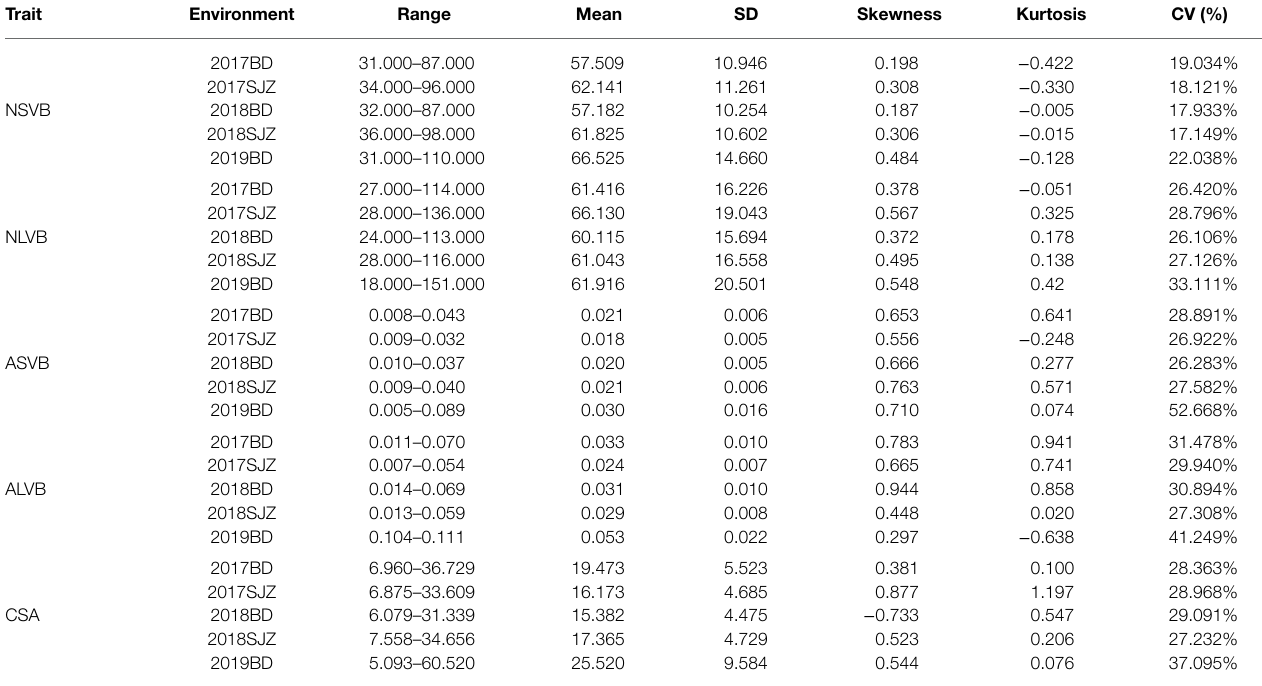
TABLE 1 | Statistical analysis of vascular bundle-related traits in different